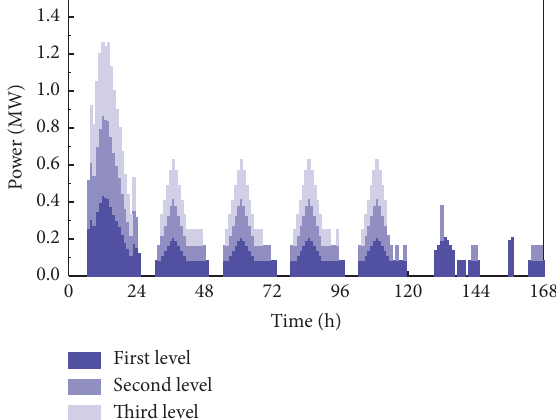
Figure 10: Electricity trading situation in day-ahead market.